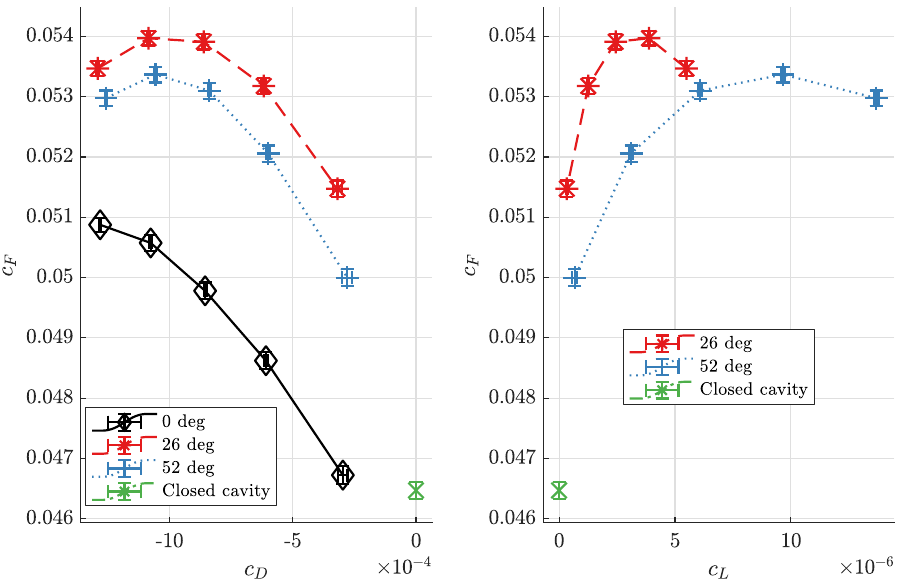
Figure 8. Change of measured axial thrust coefficients c F with through-flow coefficient c D and angular momentum coefficient c L at the relative gap width of G = 0.0125 and in the Reynolds number range of 7.5 10 7 9.6 10 7 : the closed cavity configuration is compared to centripetal through-flow at Re × ≤ ≤ × preswirl angles of 0°, 26° and